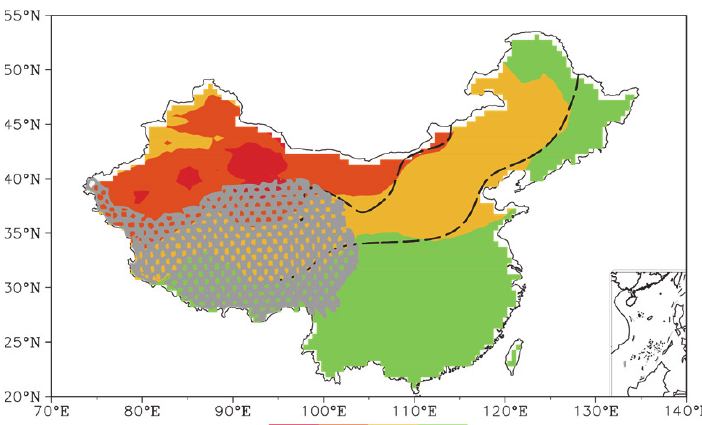
Figure 1. The spatial extent of NDPB and the aridity index in China. The aridity index (AI) is defined by the ratio of annual precipitation to the potential ET. According to the value of AI, arid climate has an AI less than 0.2 (AI < 0.2) and humid climate has an AI higher than 0.65 (AI ≥ 0.65). The NDPB has AI ranging between 0.2 and 0.65. The bold dashed lines mark the spatial extent of